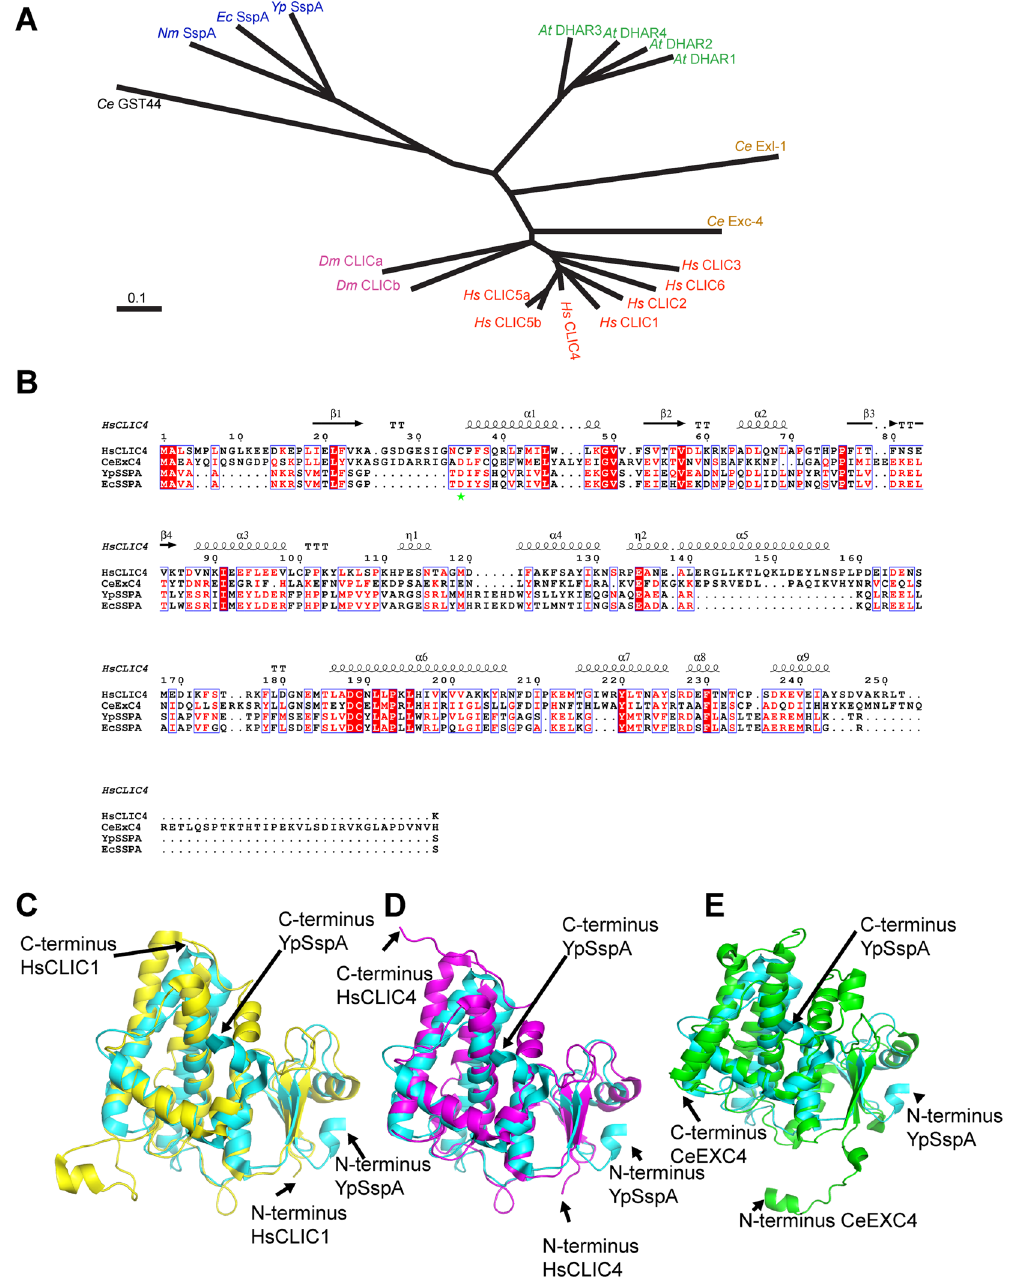
Figure 2. A prokaryotic homolog of CLIC proteins. ( A ) Phylogenetic tree of mammalian CLICs (red), Dm CLICs (pink), Ce CLICs (brown), At CLICs (green), bacterial CLICs (blue) and GST from Ce (black) showing CLICs diverged from bacterial counterparts. (B) Sequence alignment of Yp SspA, Ec SspA, Hs CLIC4 and Ce EXC4. Boxed regions indicate putative transmembrane domains (TMD1 and TMD2, respectively), red, α helices and yellow, β strands. Conserved amino acids are marked by ‘ * ’, ‘:’, and ‘.’ symbols for residues conserved in four, three and two sequences, respectively. The total number of amino acids in Yp SspA, Ec SspA, Hs CLIC4 and Ce EXC4 and are 213, 212, 253, and 290, respectively. Superposition of (C) Yp SspA (PDB code 1YYL, blue) and Hs CLIC1 (1KOM, yellow), ( D ) Yp SspA (blue) and Hs CLIC4 (PDB code 2AHE, magenta), ( E ) Yp SspA (blue) and Ce CLIC homolog EXC4 (PDB code 2YV9, green). All figures were prepared with PyMOL4. Extra helices in Ce are marked with arrows. The position of N- and C-termini are also